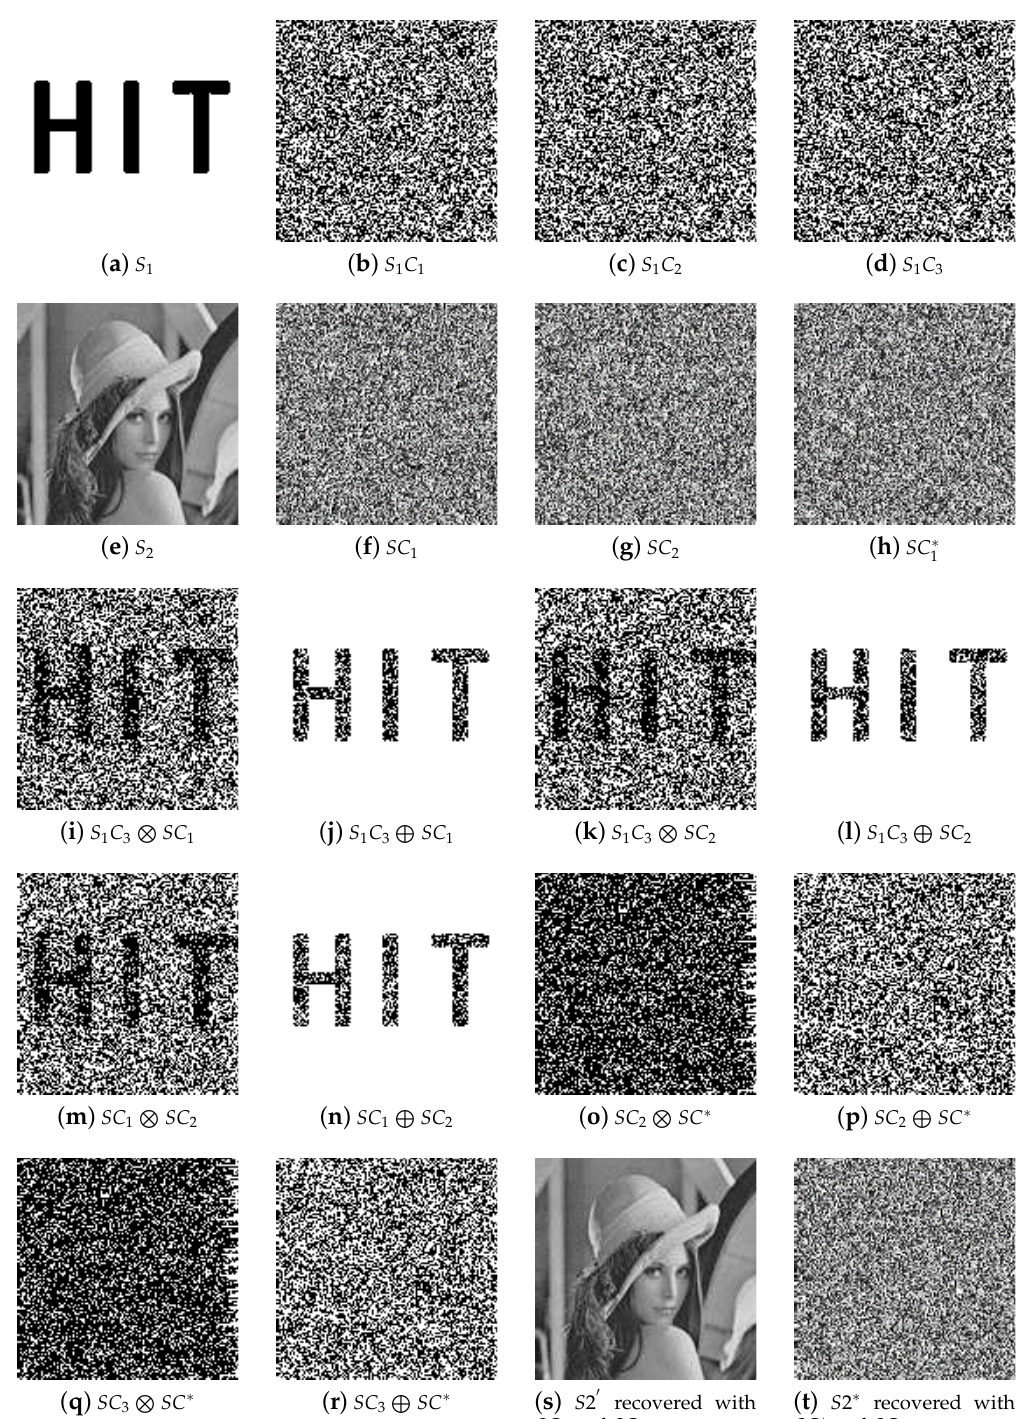
Figure 4. Results of ( 2,2 ) threshold SIS with dealer-participatory and non-dealer-participatory multual shadow authentication ability. ( a ) The binary authentication image S 1 ; ( b , c ) two binary shares S 1 C 1 and S 1 C 2 ; ( d ) the binary authentication shadow S 1 C 3 ; ( e ) the grayscale secret image S 2 ; ( f , g ) two grayscale shadows SC 1 and SC 2 ; ( h ) fake shadow SC ∗ ; ( i , j ) recovered binary authentication image with S 1 C 3 and 1 the LSB of SC 1 by stacking and XORing; ( k , l ) recovered binary authentication image with S 1 C 3 and the least significant bit (LSB) of SC 2 by stacking and XORing; ( m , n ) recovered binary authentication image with the LSB of SC 1 and SC 2 by stacking and XORing; ( o , p ) recovered binary authentication image with the LSB of SC 2 and SC ∗ by stacking and XORing; ( q , r ) recovered binary authentication image with the LSB of SC 3 and SC ∗ by stacking and XORing; ( s ) recovered grayscale secret image S 2 (cid:48) with SC 1 and SC 2 ; ( t ) recovered grayscale secret image S 2 ∗ with SC ∗ and SC 2